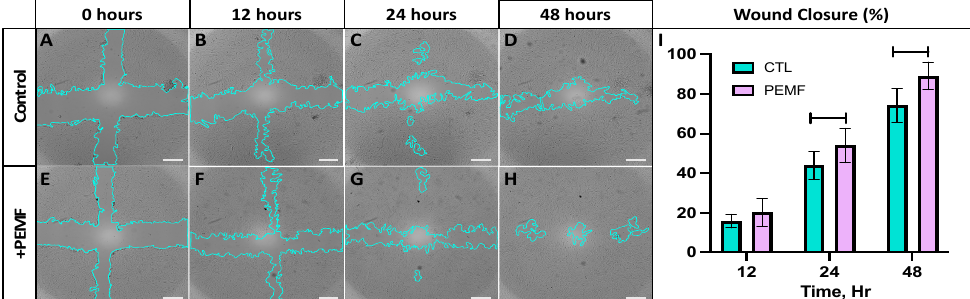
Figure 5. Representative images from in vitro wound healing assay demonstrating FLS migration into the cell ‐ free region (blue) for ( A – D ) control and ( E – H ) PEMF treated samples (Scale bar = 100 µ m). ( I ) Quantified percent wound closure of control and PEMF exposed FLS at 12, 24, and 48 h following initial cruciform injury ( n = 6 per treatment condition).